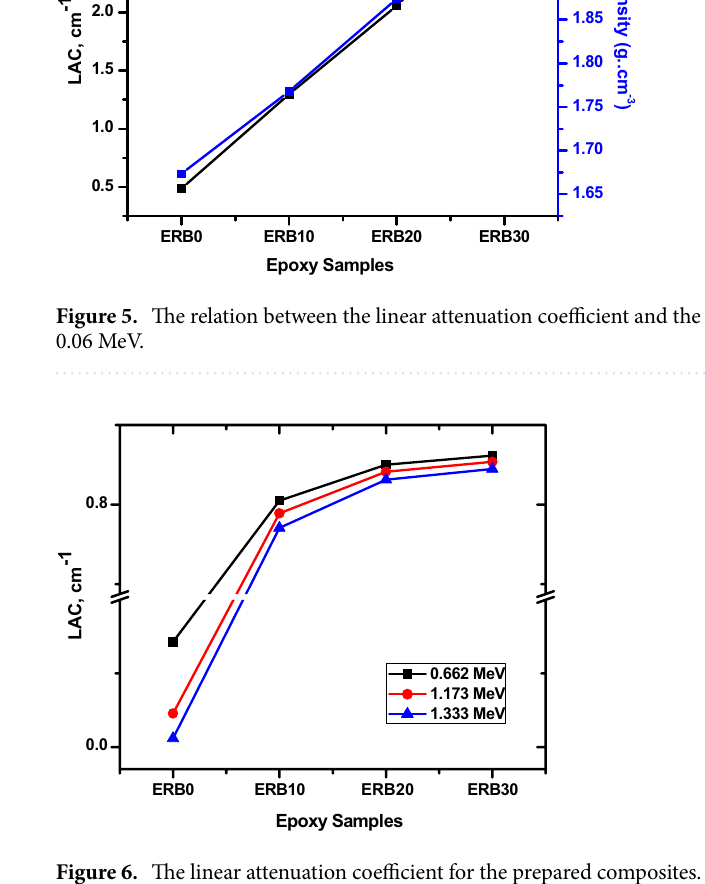
Figure 6. The linear attenuation coefficient for the prepared